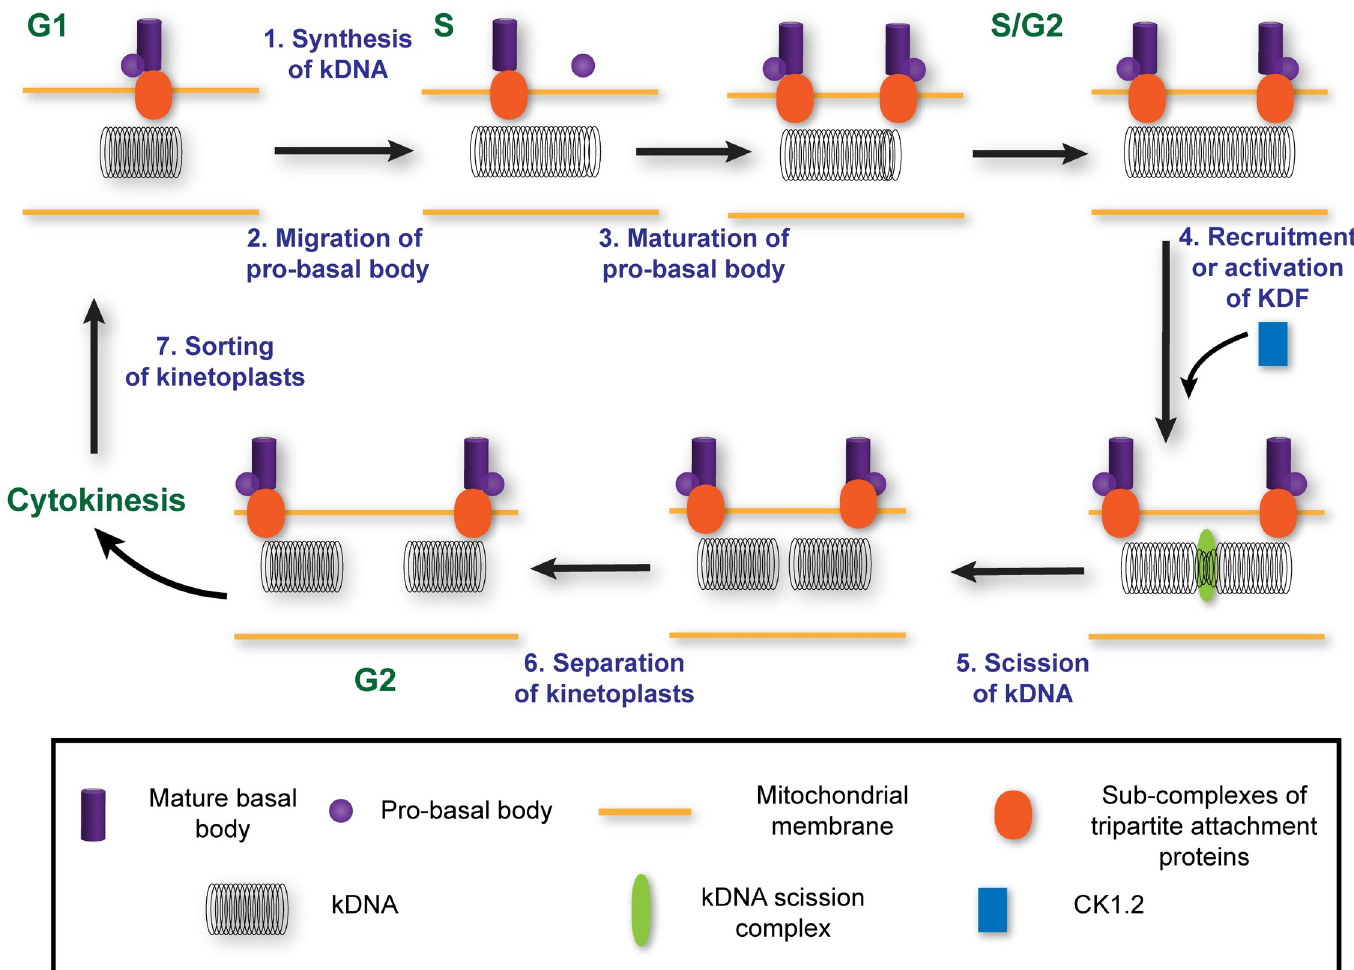
Fig 7. Kinetoplast division factor hypothesis. In G1, trypanosomes have one basal body and a single kinetoplast. During S-phase, kDNA synthesis occurs and the probasal body migrates away from the mature basal body (Step 1 and 2). After separating by a distance > 895 nm, the probasal body completes maturation (step 3) producing 1K1N trypanosomes with 2 mature basal bodies that are found near opposite ends of a kinetoplast containing uncleaved double-length kDNA [23]. We propose that presence of two basal bodies each at a pole of kinetoplast “licences” kDNA division. Subsequently, kinetoplast division factors (KDFs) are recruited close to, or into, the mitochondrion (Step 4). KDFs may recruit or activate a “kDNA cleavage/scission complex” to divide the kinetoplast (Step 5). In G2, separation of kinetoplasts is visible (Step 6), providing microscopic evidence of kDNA scission. Sorting of kinetoplasts into daughter trypanosomes occurs at cytokinesis (Step 7). Depiction of a “kDNA cleavage/scission complex” is hypothetical. Knockdown of TbCK1.2, or other KDFs, prevents scission of kDNA (see Fig 2). Molecular functions of other KDFs remain to be discovered. TAC-protein sub-complexes are projected to might mediate scission site selection and/or sorting of kinetoplasts (reviewed in [11]).